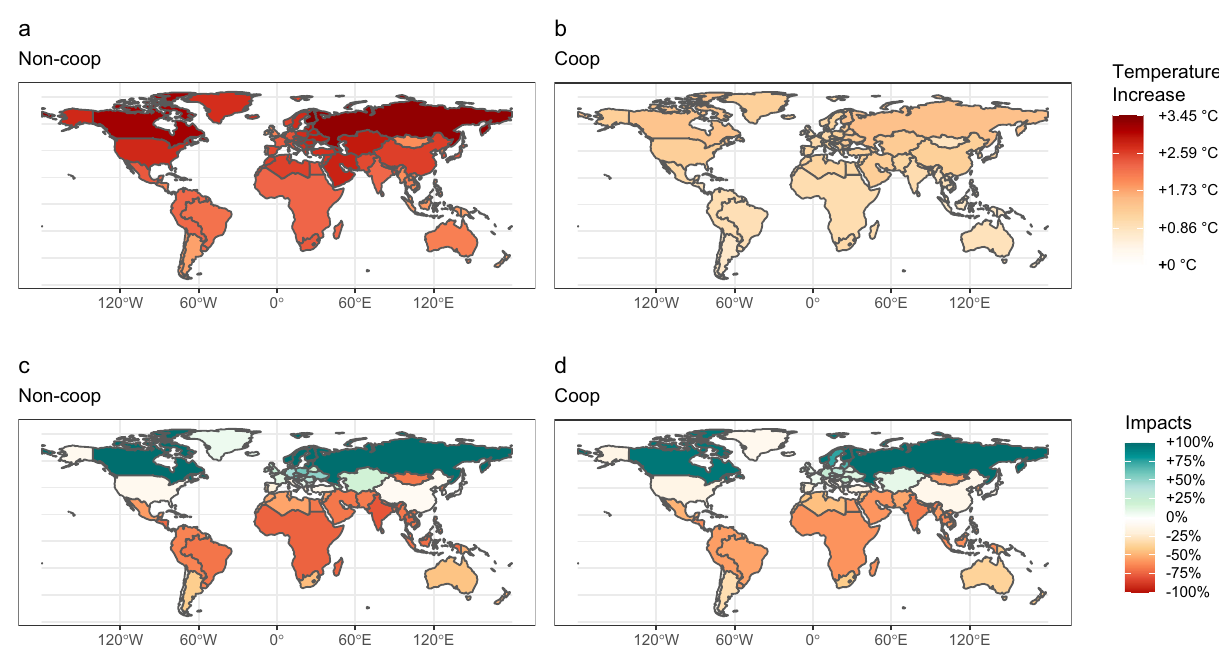
Fig. 5 Map of population-weighted temperature increases and climate impacts projected in 2100. a , b Local temperature increases are compared to the 1980 – 2010 average. c , d Impacts [% of GDP] projected for the year 2100. All scenarios use the default speci fi